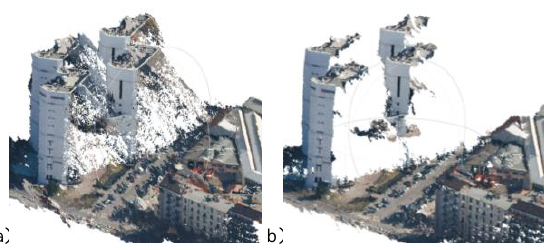
Figure 4. Examples of the original point cloud (a) and the filtered one after the removal of the mixed pixels (b).